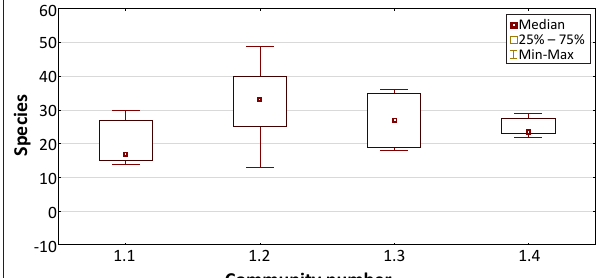
FIGURE 3: Species abundance of the communities within major community 1.